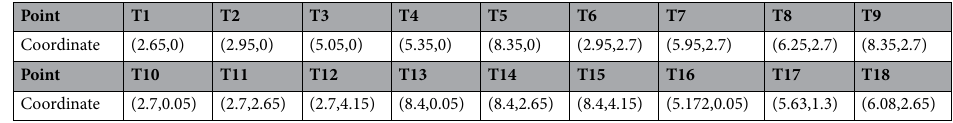
Table 1. Location of each measured point from the explosion source